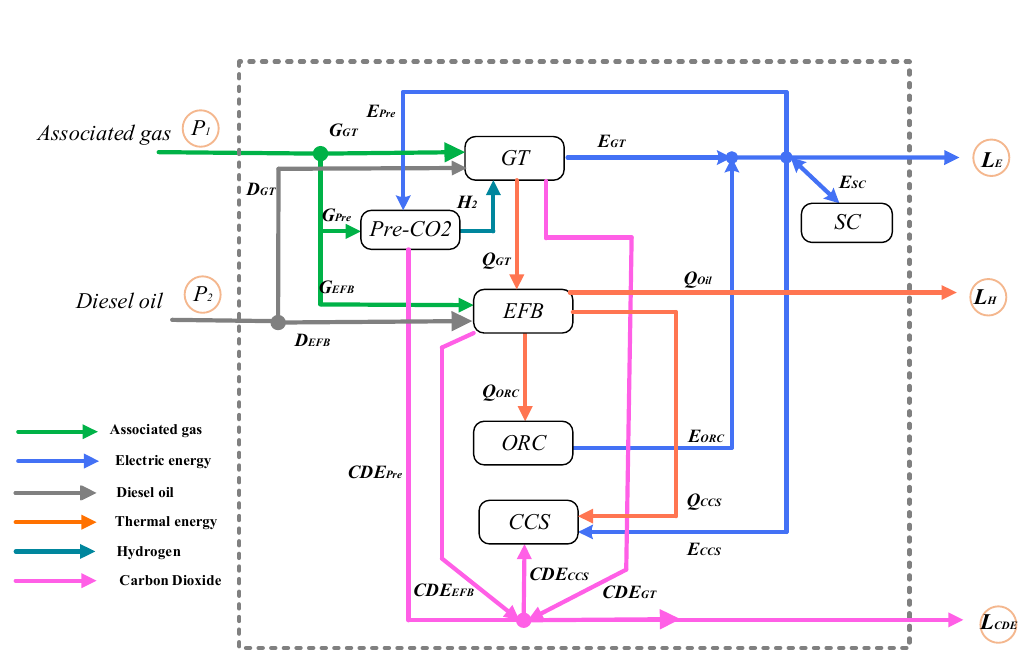
Figure 4. Energy and Emission Flow Mapping of IESs.